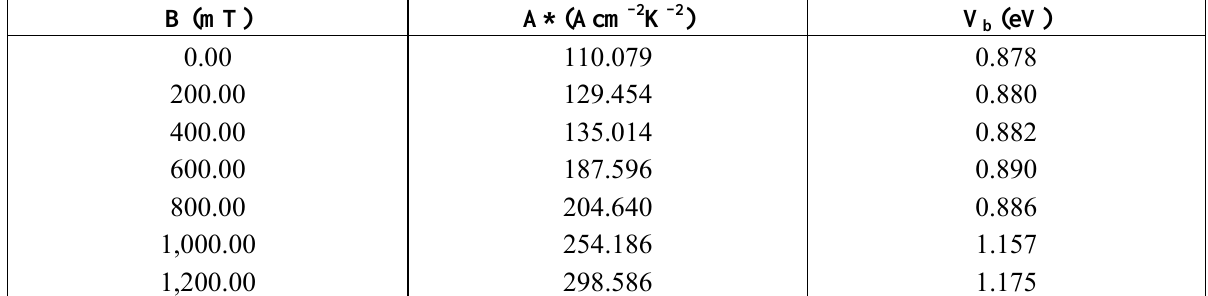
Table 1. Potential barrier via magnetic field in gold-DNA-gold structure (V Richardson constant (A*) via magnetic field in gold-DNA-gold